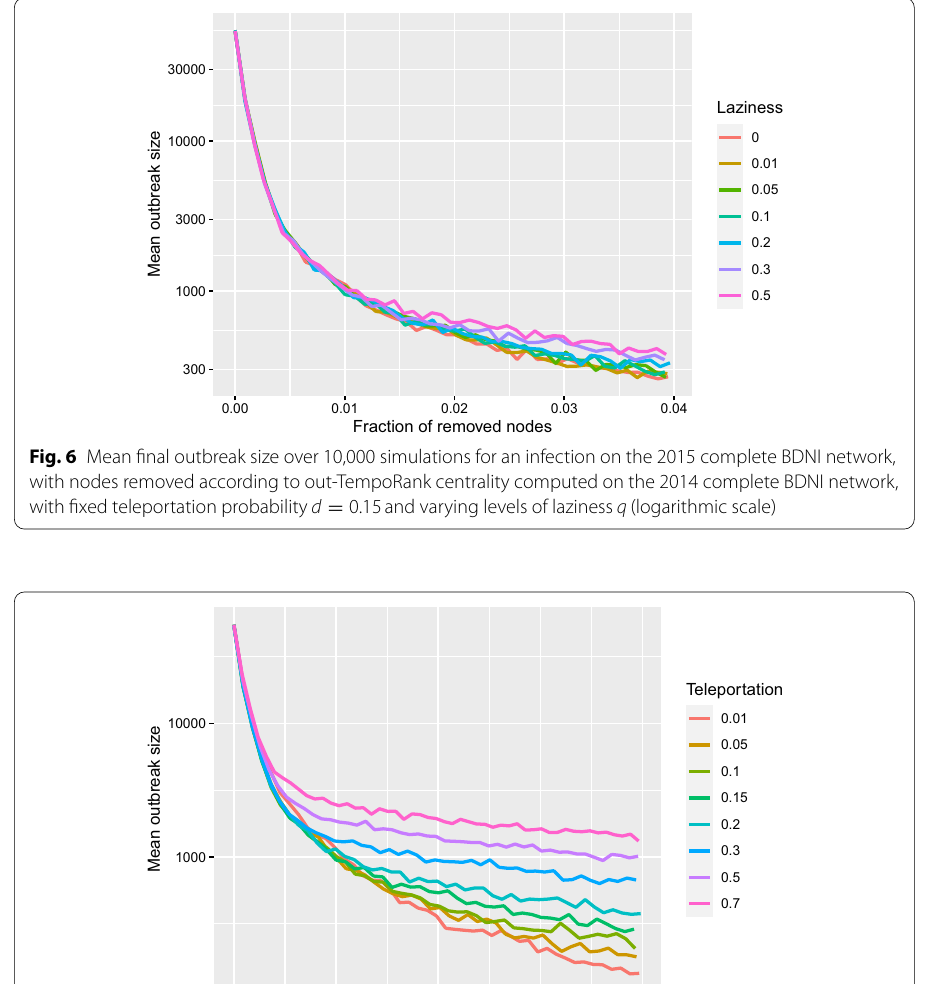
teleportation was set to the lowest levels ( d = 0.01 ). We then used TempoRank and